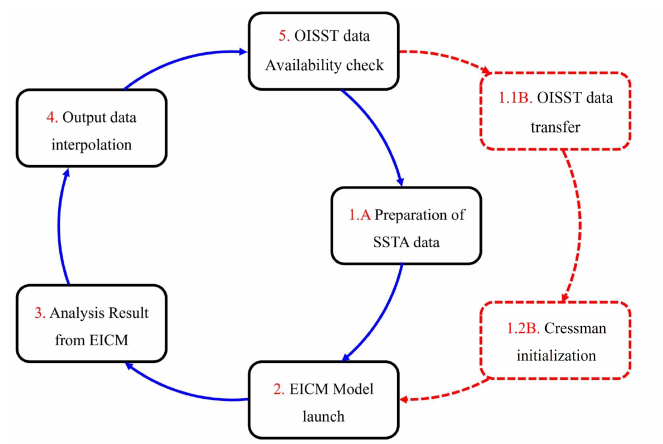
Figure 3. CIEICM with the operational assimilation working scheme.